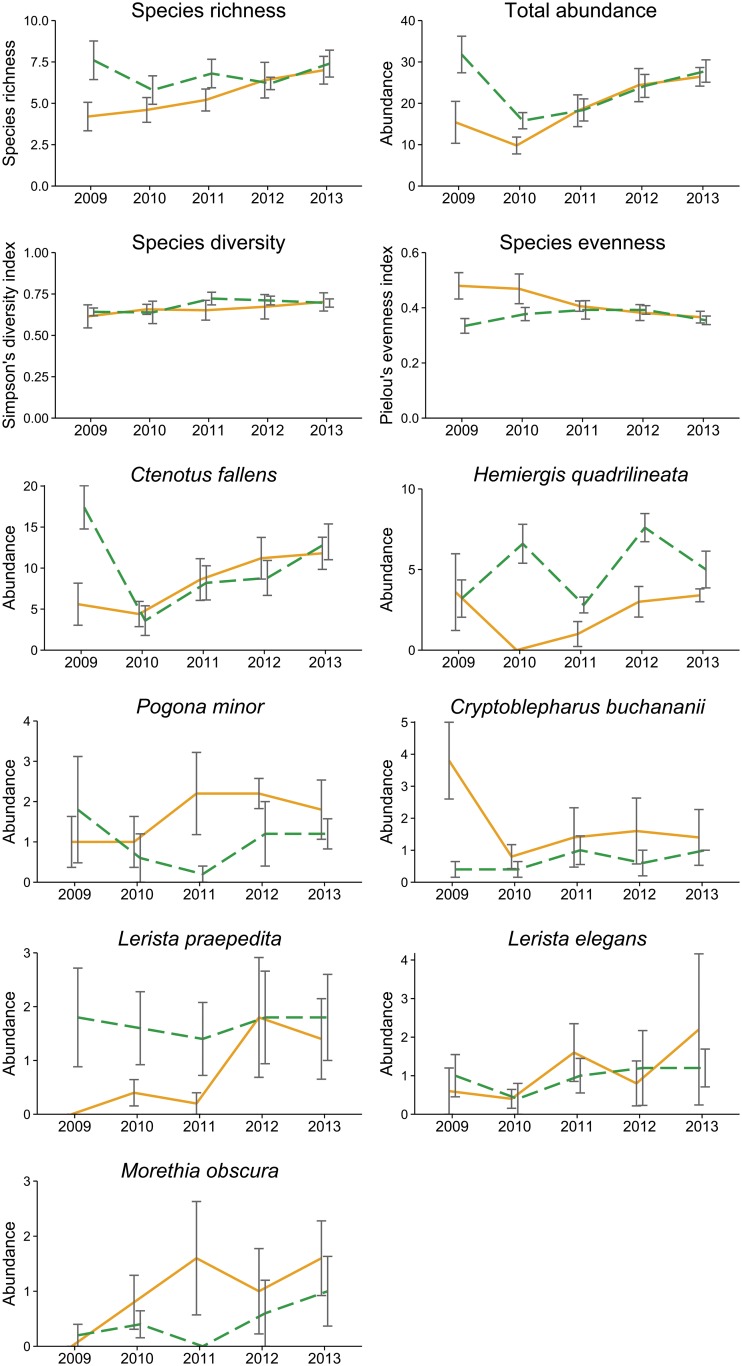
Mean and standard error of reptile abundance, species richness, diversity and evenness at burnt (solid orange line) and unburnt (dashed green line) sites in each year.